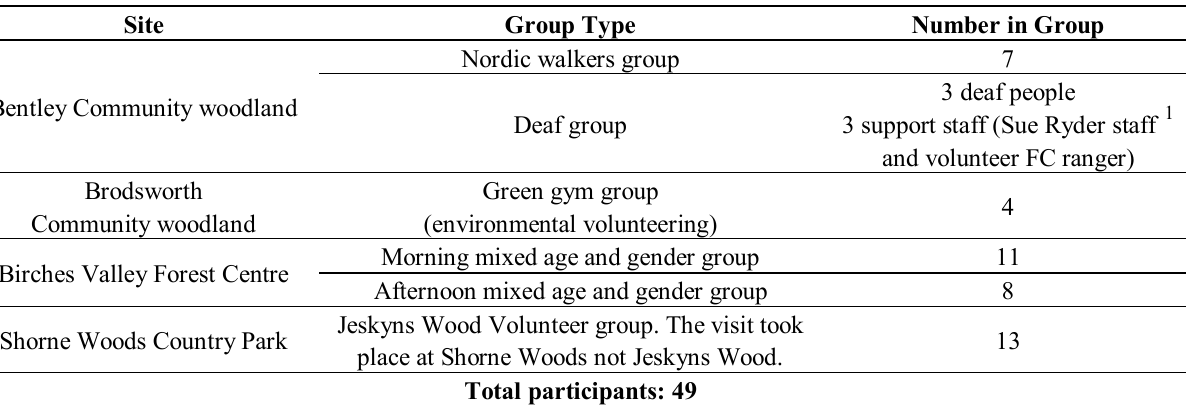
Table 2. Participants involved in the